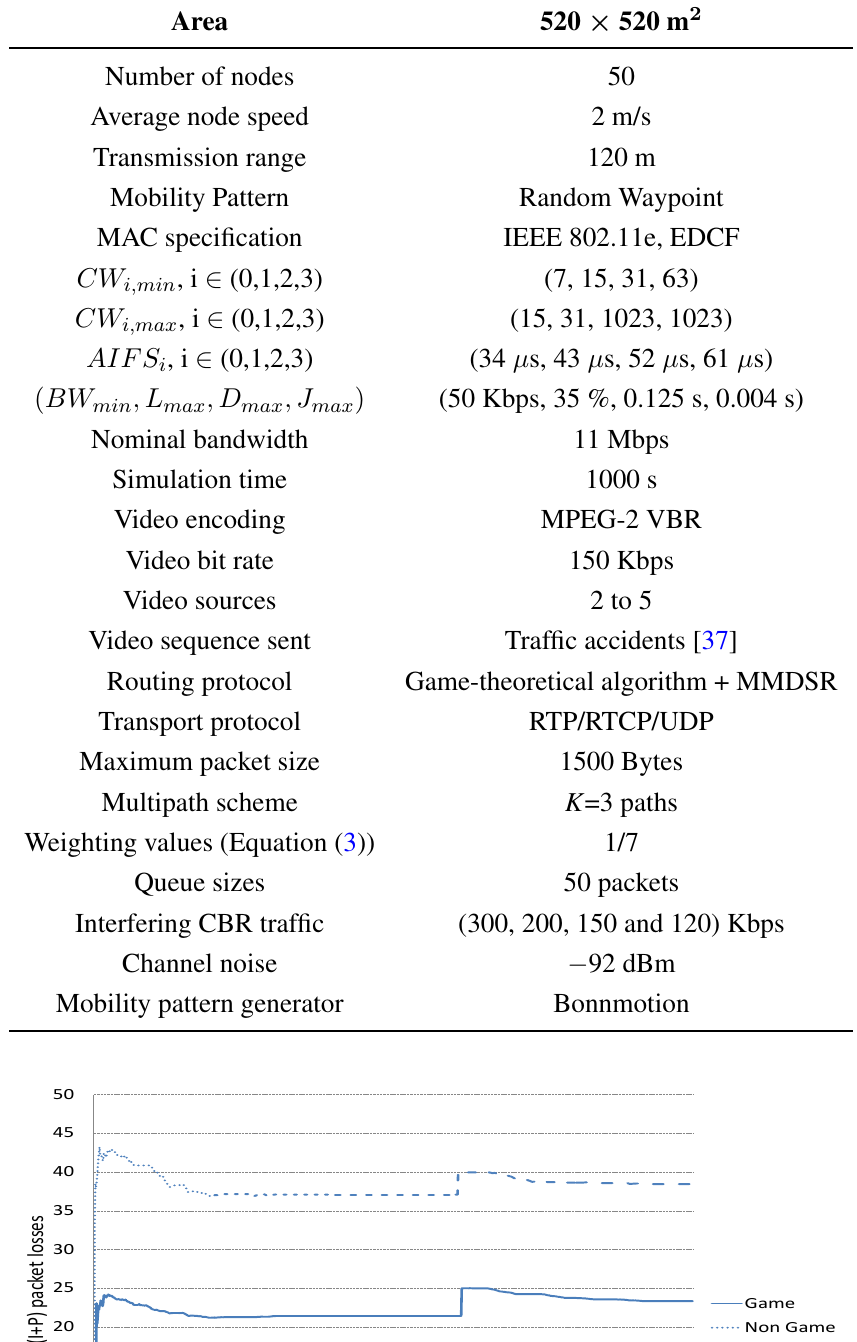
Table 3. Simulation settings of the MANET scenario.